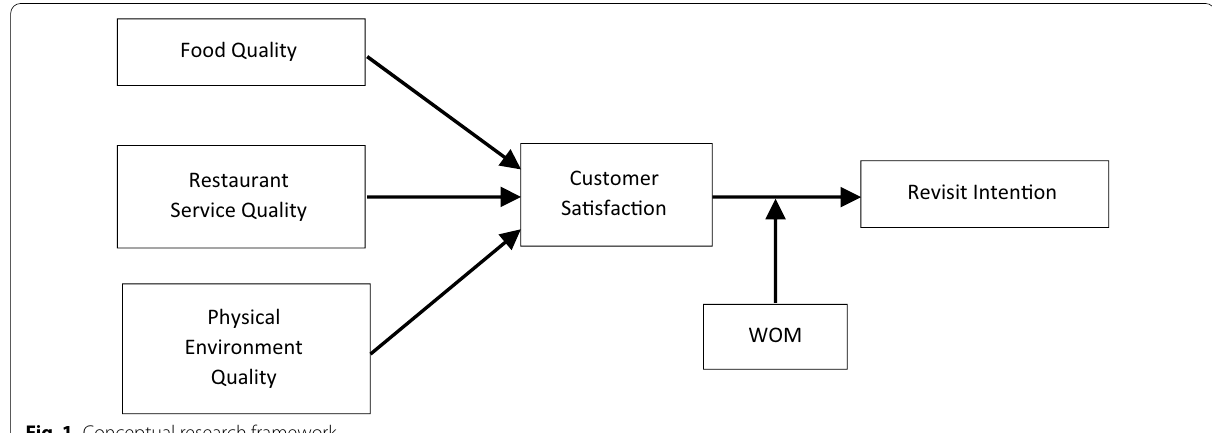
Fig. 1 Conceptual research